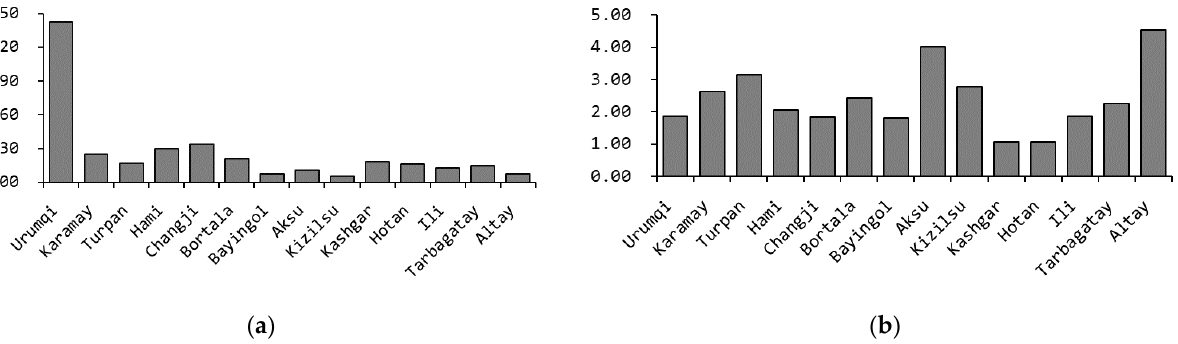
Figure 4. The indicators of the convenience of medical treatment in the districts of Xinjiang, ( a ) Indicator D 12 ; (b) Indicator D 13 .